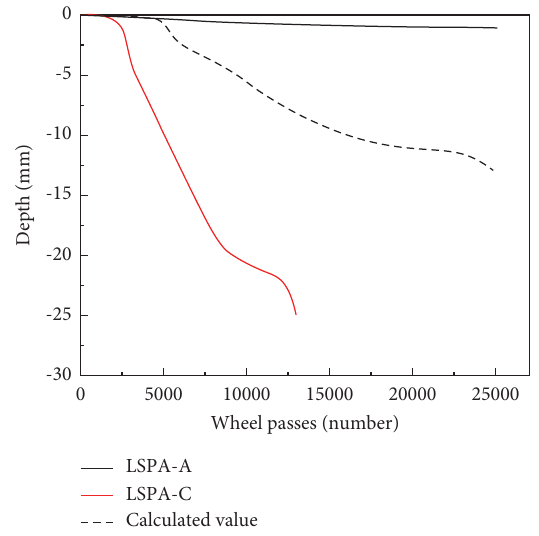
Figure 32: Depth profile for EAM [25]. Note: LSPA � blend of EA, LSP, and sand; calculated value � average depth of LSPA A and C. Table 6: Marshall of epoxy resin concrete and epoxy asphalt concrete [7].